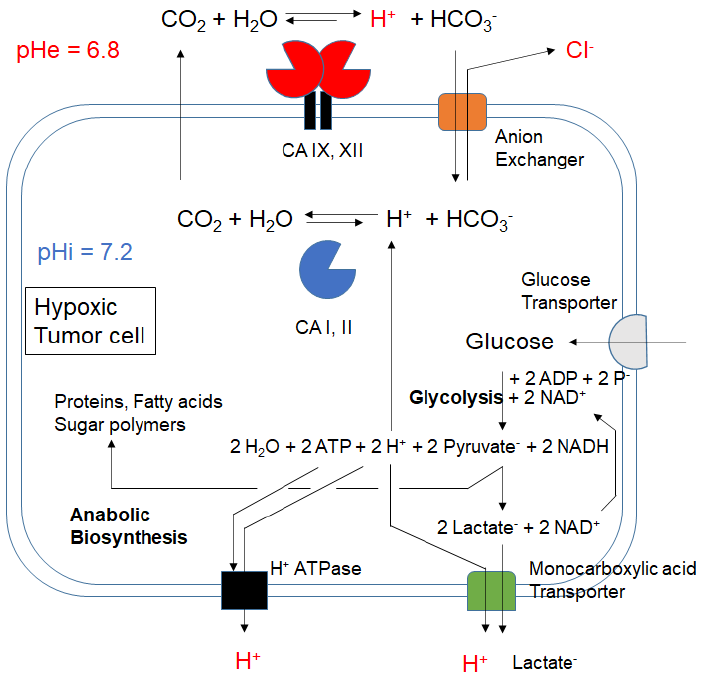
Figure 1. Schematic representation of the central role played by overexpressed membrane-bound carbonic anhydrase (CA) isozymes CA IX and CA XII in tumor metabolism and tumor pH homeostasis: glycolysis is significantly upregulated in tumor cells to make ATP under hypoxic conditions. Protons produced via glycolysis are transported outside the cell via various mechanisms, with cytosolic (CA I and CA II) and membrane-bound CA isozymes (CA IX and CA XII over-expressed in hypoxic tumors) playing a central role. Interfering with tumor pH homeostasis through the inhibition of CA IX and CA XII thus has the potential to control and suppress the proliferation of cancer cells.